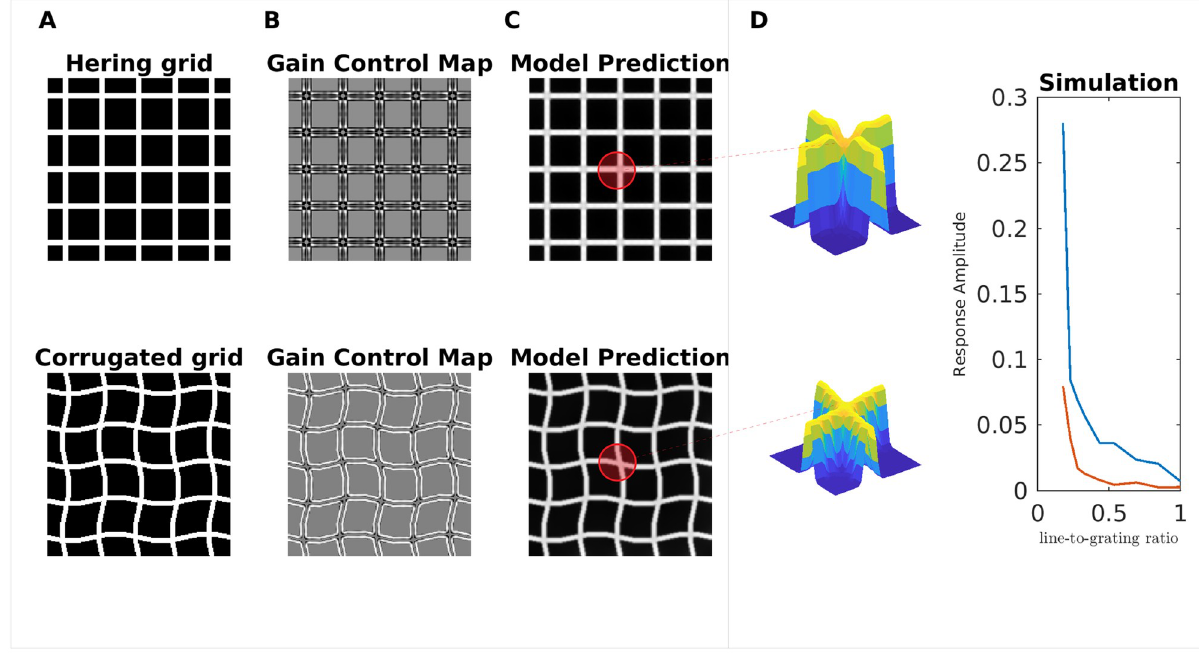
Fig 18. Model predictions for Hermann/Hering grid and corrugated grid. (A) Hermann/Hering (HG) illusion and a corrugated version of it. At the intersections of the white grid lines, illusory gray spots are perceived in the HG, but not in the corrugated grid. (B) The corresponding gain control maps of the input images of A. (C) The brightness estimation from our model. The surfaces plots (insets) illustrate the 3D profile of the brightness estimation corresponding to regions highlighted with red. (D) The predicted brightness magnitude at the intersections as a function of the ratio , where the red curve corresponds to the corrugated grid, and the blue curve to the HG. line width grating width